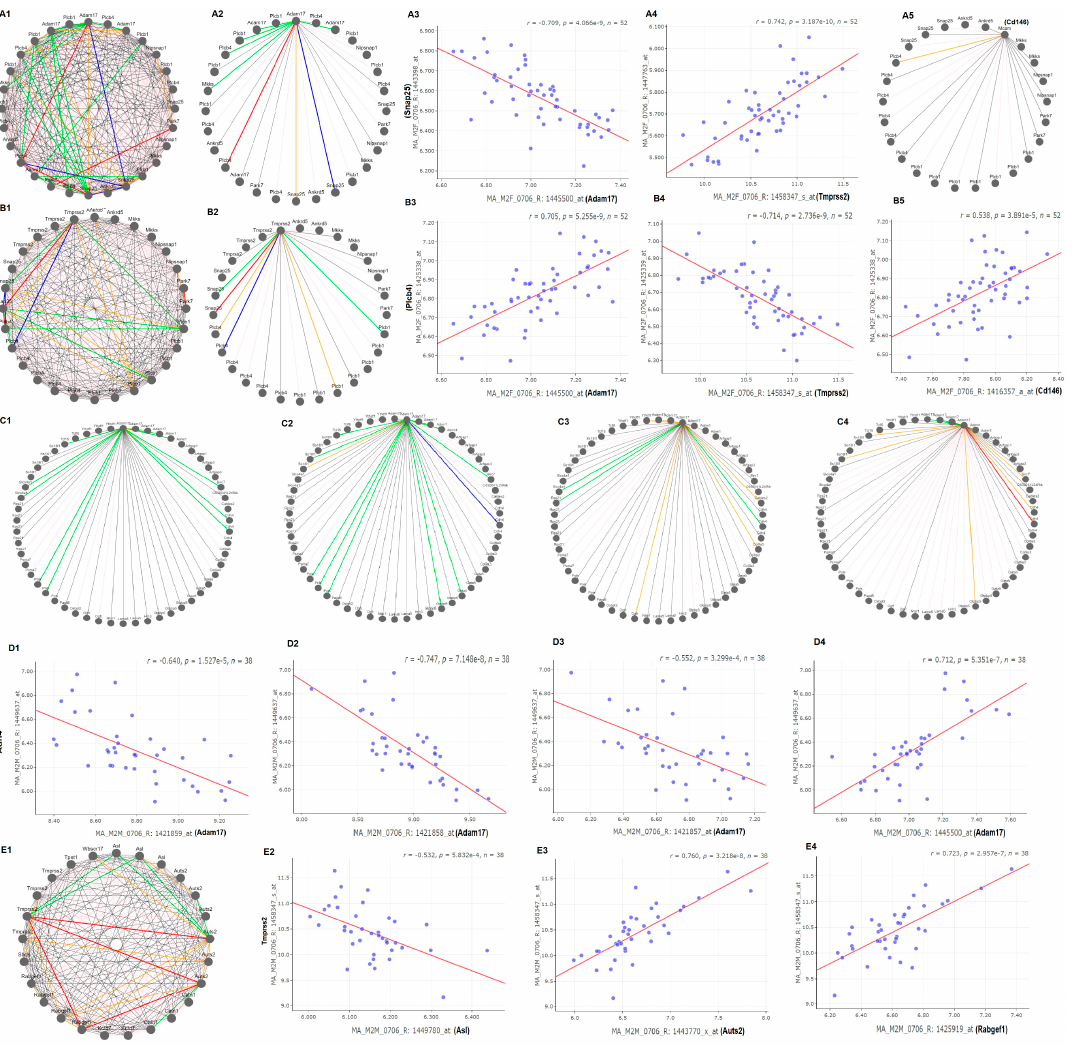
Figure 4. Candidate for eQTL of the Ace2 complex between female and male mice. In ( A1 – A4 , C1 – C4 , D1 ) the correlations among genes are indicated by lines with different colors and thickness. The thick wide solid red lines and blue lines indicates the absolute value of r is more than 0.75, representing the positive or negative correlation between the genes on both ends of the connection.The thin solid pent and green lines indicate the absolute value of r is between >0.35 and <0.75, represent the positive and negative correlations. The dashed lines indicate the absolute value of r is <0.35, no correlations. ( A1 – A5 , B1 – B5 ) are for female. ( C1 – C4 , D1 – D4 , E1 – E4 ) for male mice. Red and purple colors for positive, blue and green for negative correlation, and other colors for non-correlation in network graphic structures in ( A1 – A5 , B1 – B5 , C1 – C4 , D1 – D4 , E1 , E2 ) are correlation scatterplot of expression levels in gene pairs in either positive or negative